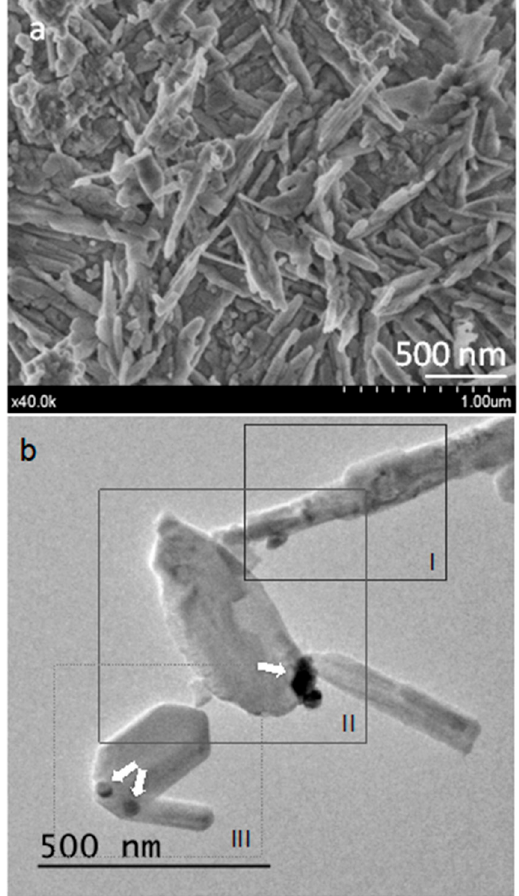
Figure 1. Electron microscopy images of un-hydrated MTA Repair HP material: ( a ) field emission gun scanning electron microscopy (FEG-SEM) secondary electron micrograph; ( b ) TEM bright field image.